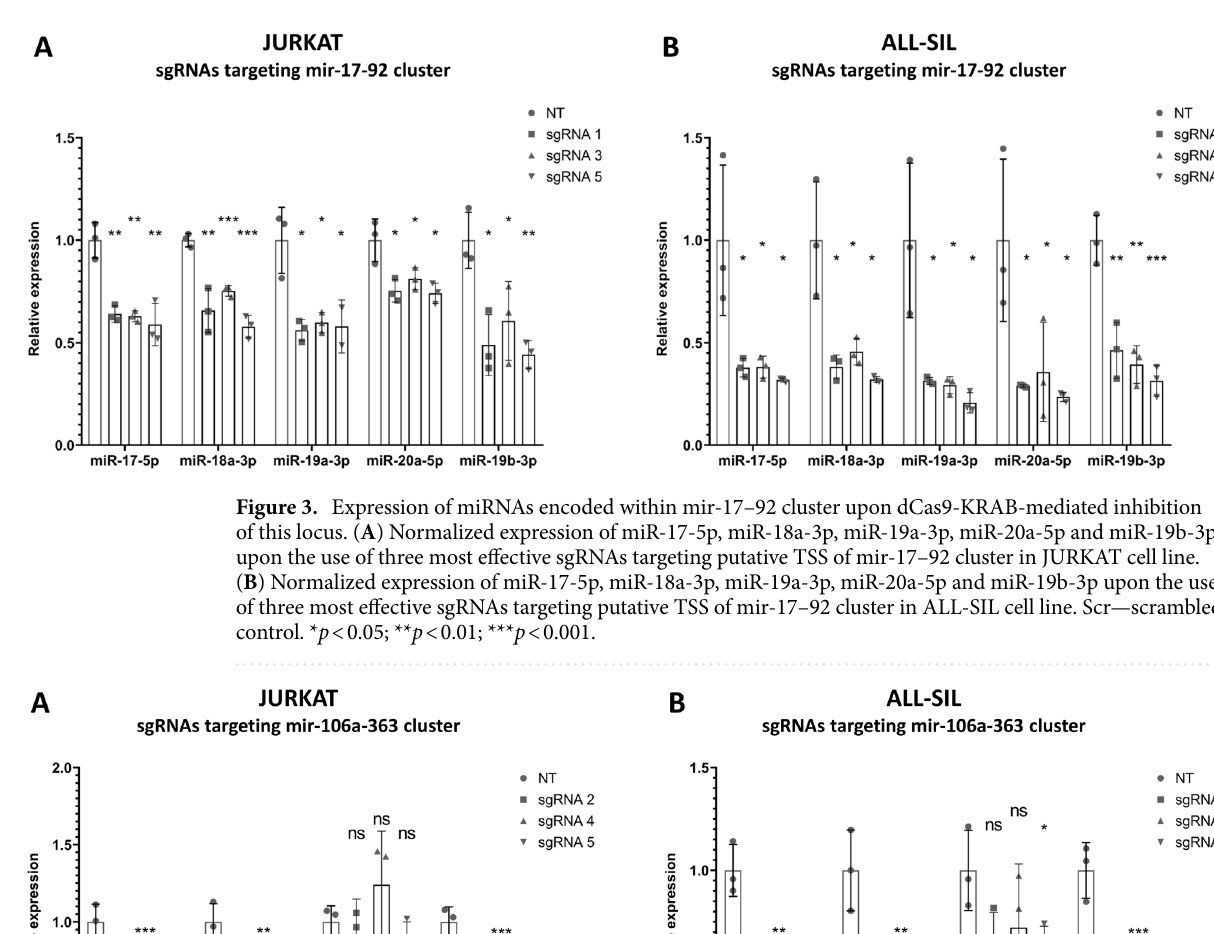
Again we observed increased expression of miR-130a-3p upon repression of miR-130b-3p, which may be indica- tive of the existence of compensatory mechanisms.